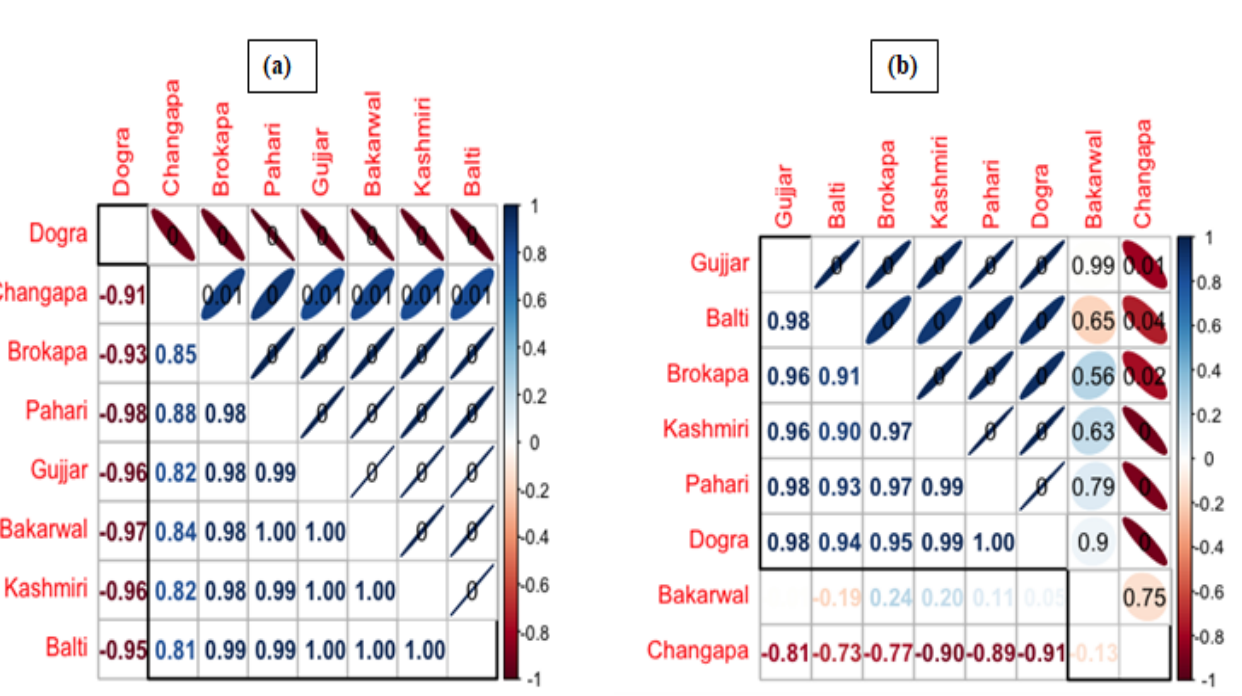
Figure 4. Correlogram showing the Pearson correlation results between ethnic groups evaluated in the 3 regions for ( a ) wild and ( b ) domestic animals.